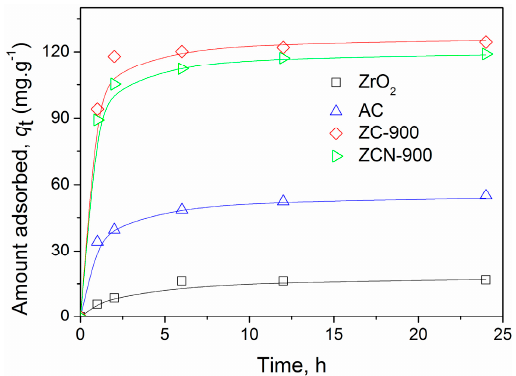
Figure 6. Effect of contact time on adsorption of CV on different adsorbents (initial CV concentration = 50.2 mg·L − 1 ). The solid lines show the calculated results derived from pseudo-second order non-linear method.